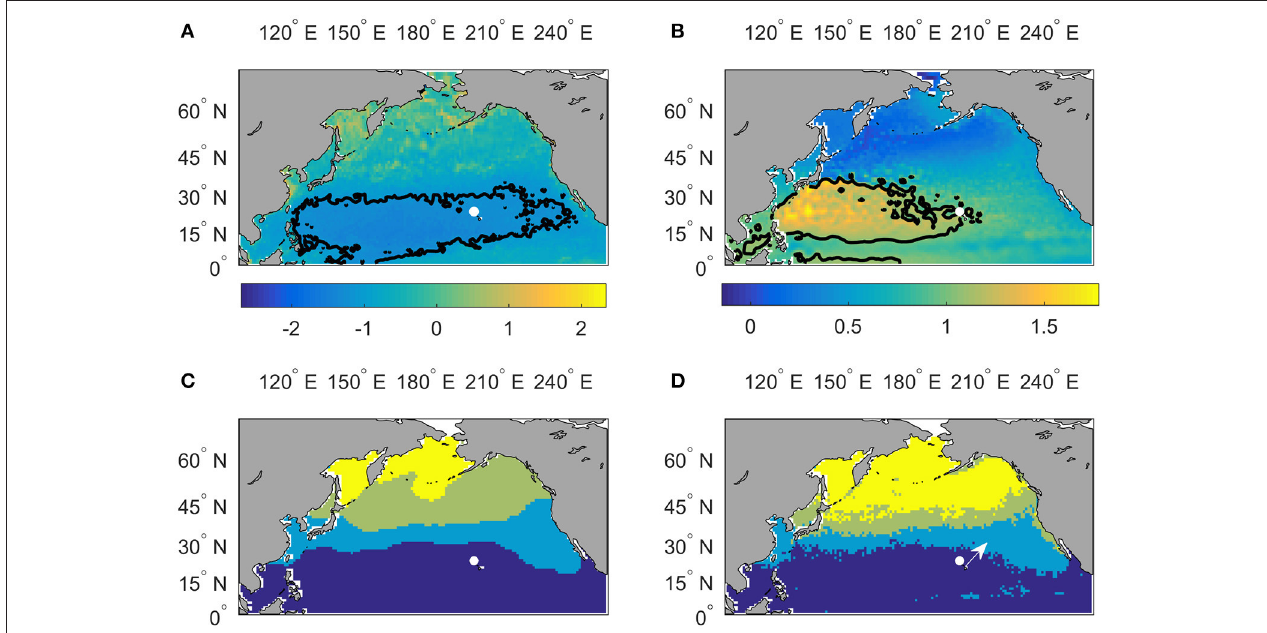
FIGURE 1 | Extent of the North Pacific Subtropical Gyre (NPSG) for June of 2003, showing (A) oligotrophic threshold ( ≤ 0.07mg m − 3 ) satellite ocean color derived surface chlorophyll, chl a ; (B) geostrophic recirculation defined by the 1.05m absolute dynamic height relative to the geoid; and multivariate seascapes classified from (C) CESM-BEC model output and (D) satellite data. Dark blue, subtropical seascape; light blue, oligotrophic boundary seascape; green, transition seascape; yellow, subarctic seascape. Arrow in (D) shows distance between Station ALOHA (white circle) and the boundary of the subtropical seascape.